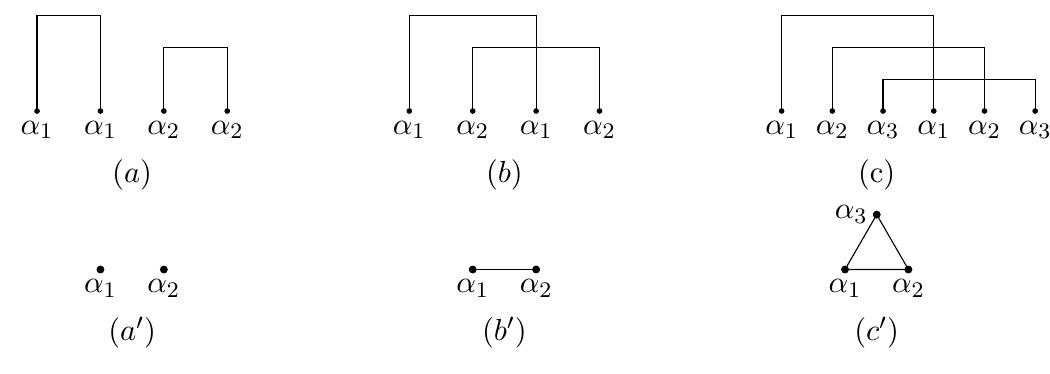
Figure 2 . Three examples of chord diagrams ( a ),( b ), ( c ), and the corresponding intersection graphs ( a 0 ), ( b 0 ) and ( c 0 ). In particular ( b ) and ( b 0 ) represent the value of (cid:17) in eq.